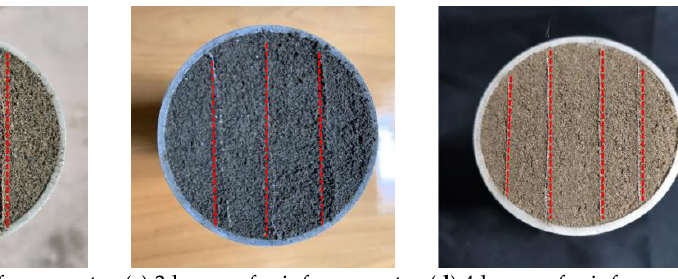
5 of 11 Figure 3. Laying method of the reinforcement belt in the reinforced tailings dam. Figure 4. The layout of reinforcement. ( a ) Bisection of sample